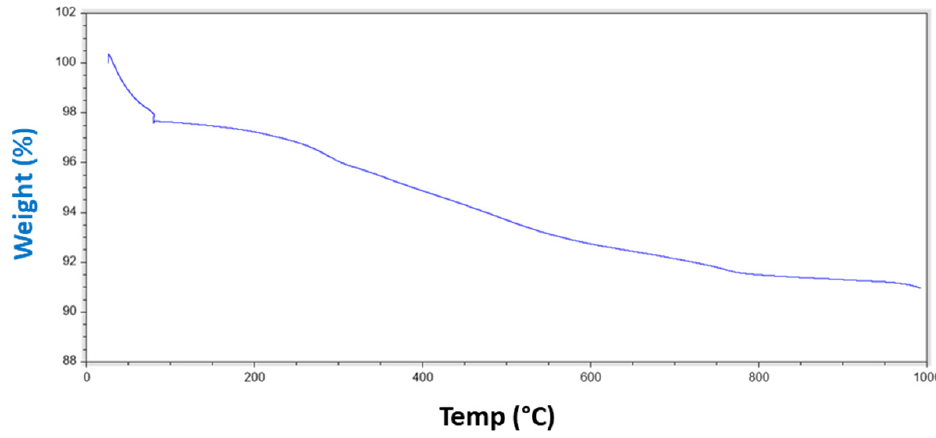
Figure 4. Thermogravimetric analysis (TGA) curve of the as-received hydrophobic silica.